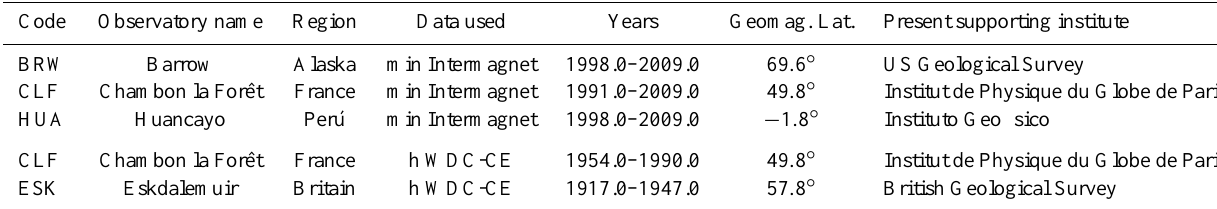
Table 1. Summary of observatories and data used. Geomagnetic latitudes are calculated for a 2005 dipole.